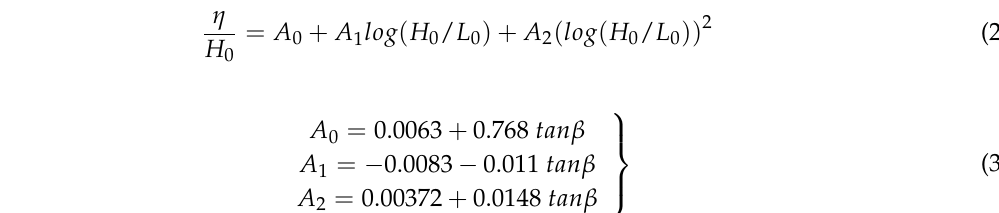
Figure 14. A schematic illustration of the shift in the estimated shoreline position due to ( a ) wave set-up or ( b ) wave run-up.